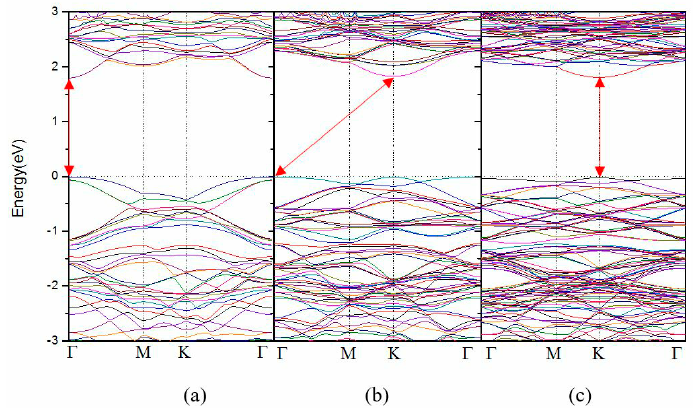
Figure 4. Band structure of different sizes of monolayer WS 2 supercell with one substitutional O atom: ( a ) 3 × 3 × 1; ( b ) 4 × 4 × 1; and ( c ) 5 × 5 × 1. The band gaps are shown with red